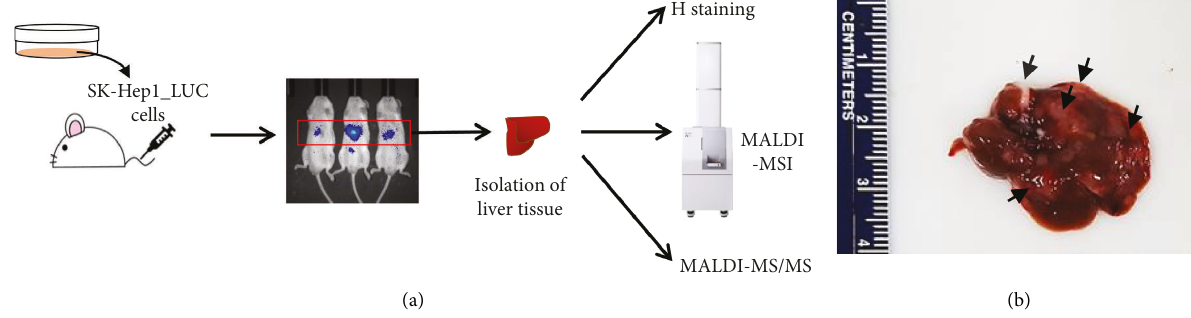
Figure 1: Analysis procedure. (a) Scheme of metastasis model and imaging analysis. (b) Liver cancer metastasis in mouse liver tissues (black arrow, liver cancer metastasis).